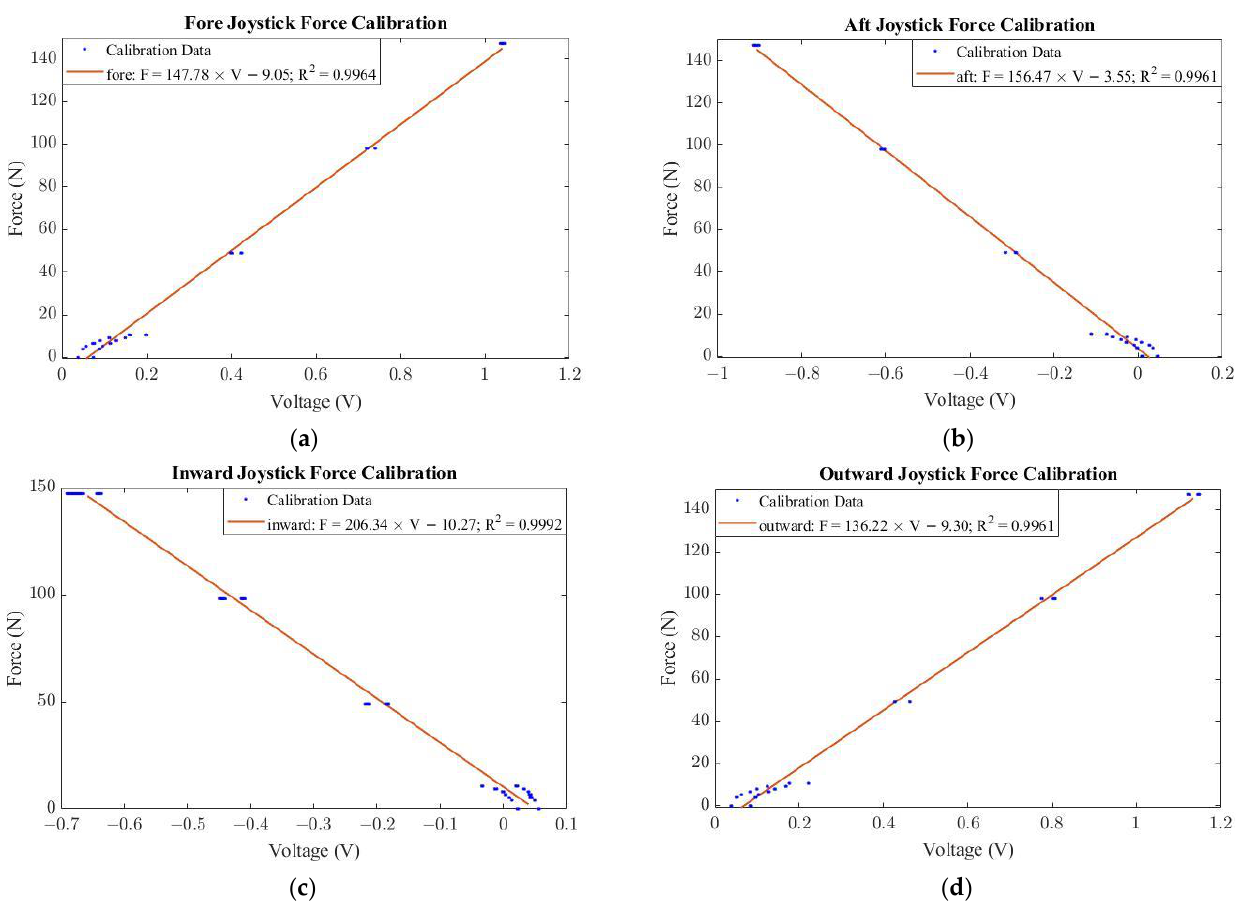
Figure 3. Calibration data and equations for the full-bridge strain gauge setups, which were used to measure force application in the fore ( a ), aft ( b ), inward ( c ), and outward ( d ) joystick movement directions. Calibration equations are shown for each graph where F is force (N), and V is strain gauge voltage (V). Note: All forces shown in Figure 3 are shown as positive, although joystick input forces in the aft and inward directions were negative due to negative input voltages from the strain gauges.